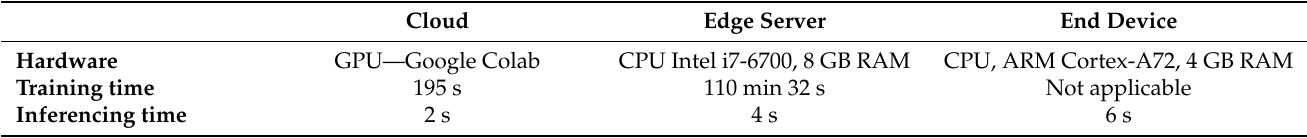
Table 4. Training and inferencing results in three different computing